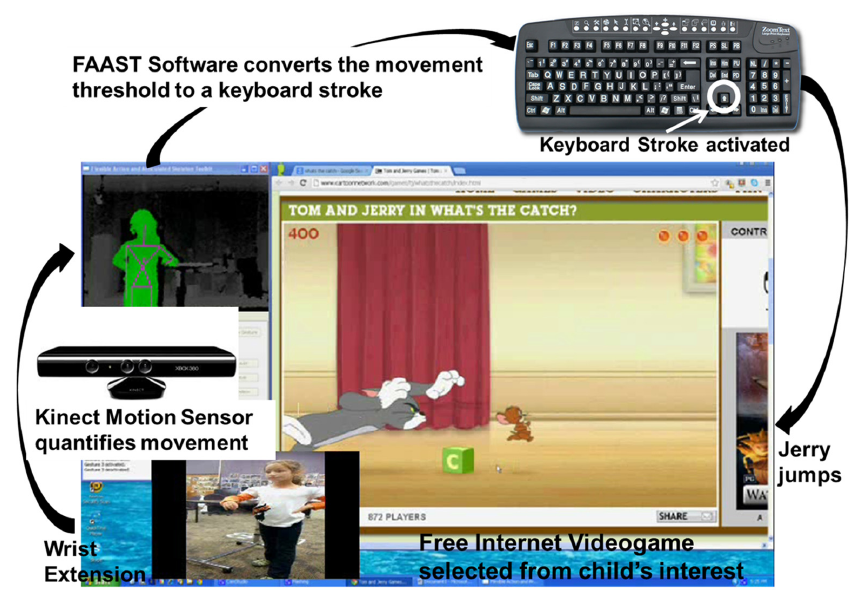
Figure 5. Movement therapy using free videogames, Kinect and FAAST software. The participant performs the motion. The Kinect converts segment/joint motion to XYZ coordinates. FAAST software identifies movement threshold and activates keyboard stroke. Jerry jumps.